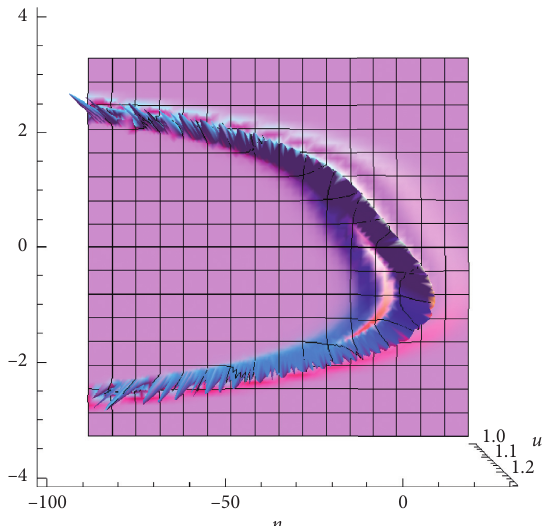
Figure 7: Spatiotemporal structure of the semidiscrete three-soliton solution determined by solution (53) with the parameters α � t , α � t 3 , α � sech 2 t , c α 1 2 3